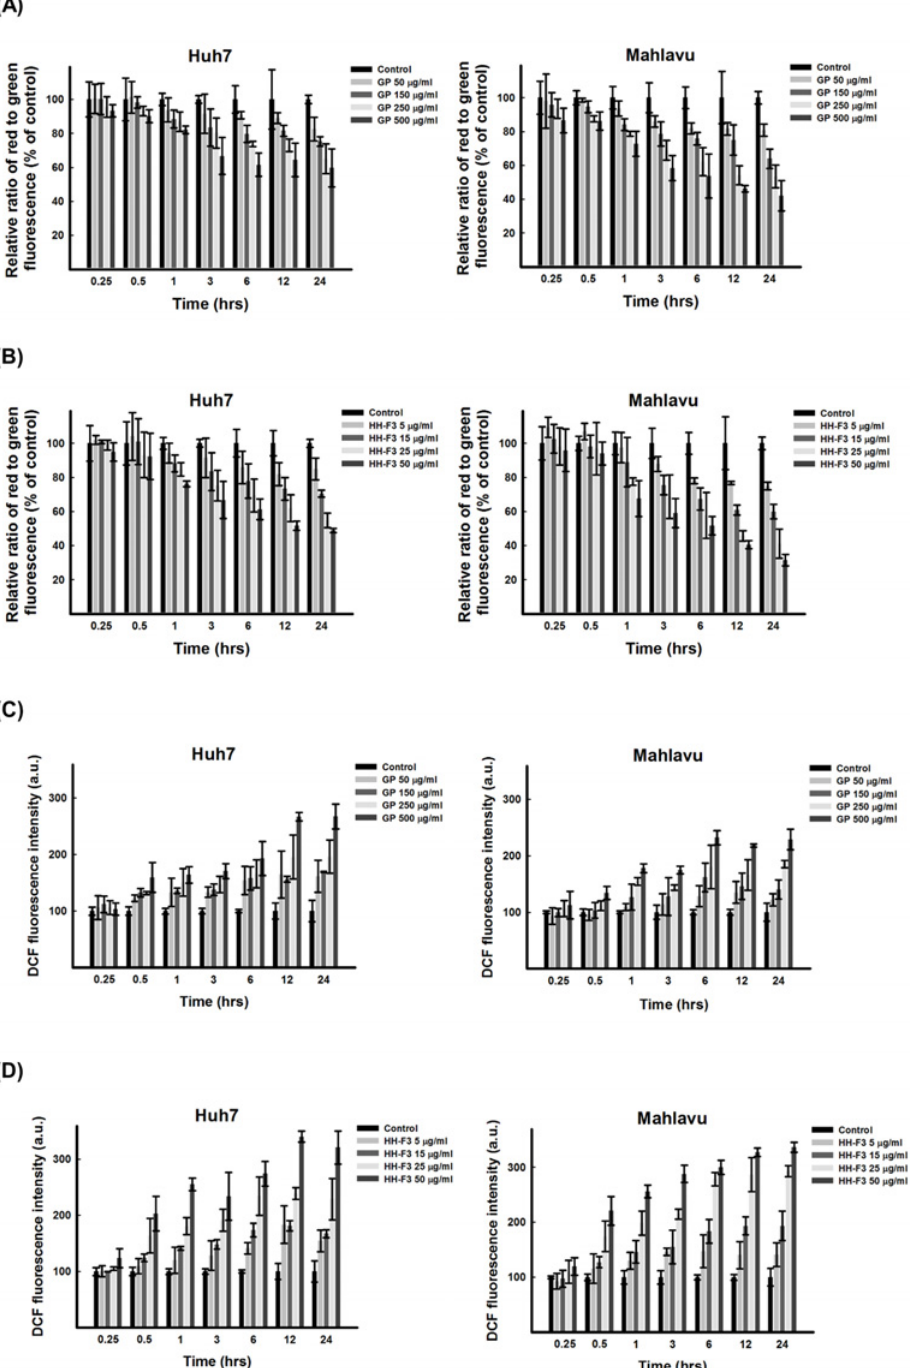
Fig 3. Disruption of mitochondrial membrane potential and increase ROS generation in HCC cells treated with 30% DMSO GP extracts and HH-F3. (A-B) The mitochondrial membrane potential ( ΔΨ ) in Huh7 and Mahlavu cells was analyzed using the JC-1 mitochondrial membrane potential assay. The ΔΨ of the cells was lower in the HCC cells treated with the 30% DMSO GP extracts and HH-F3 than in the control HCC cells. The treatment effect as a function of time (0.25, 0.5, 1, 3, 6, 12, and 24 hrs) is shown (n = 3). (C-D) Intracellular peroxide levels, as measured by DCFH fluorescence, were increased after treatment with different concentrations of 30% DMSO GP extracts and HH-F3. The treatment effect as a function of time (0.25, 0.5, 1, 3, 6, 12, and 24 hrs) is shown (n = 3).